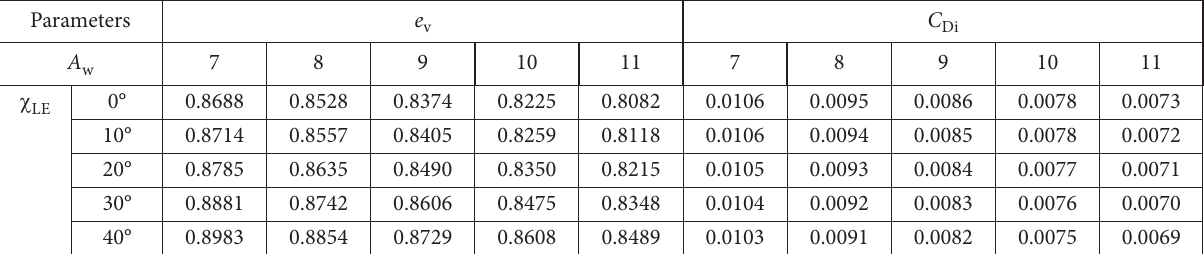
Table 1. Dependence of changes in e and С Di on sweep and wing aspect ratio Parameters e v C